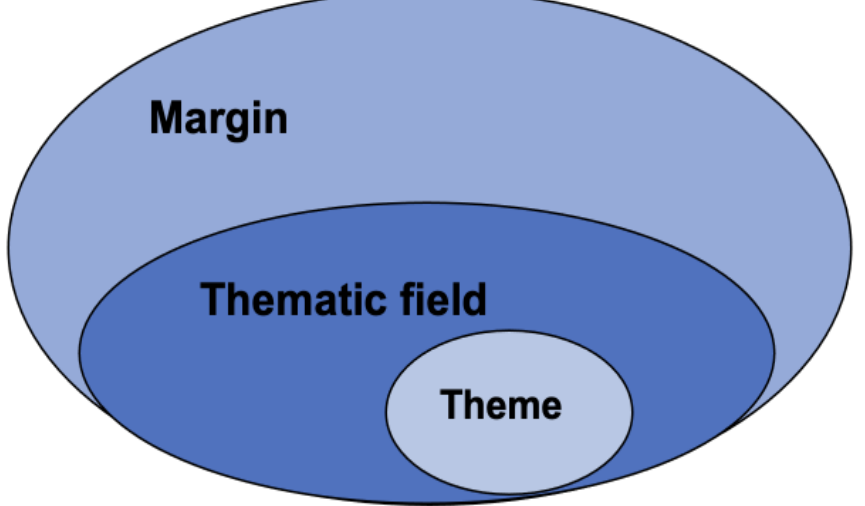
Figure 4. An illustration of the relations between theme, thematic field, and margin, as conceived by Aron Gurwitsch [96,110,112].